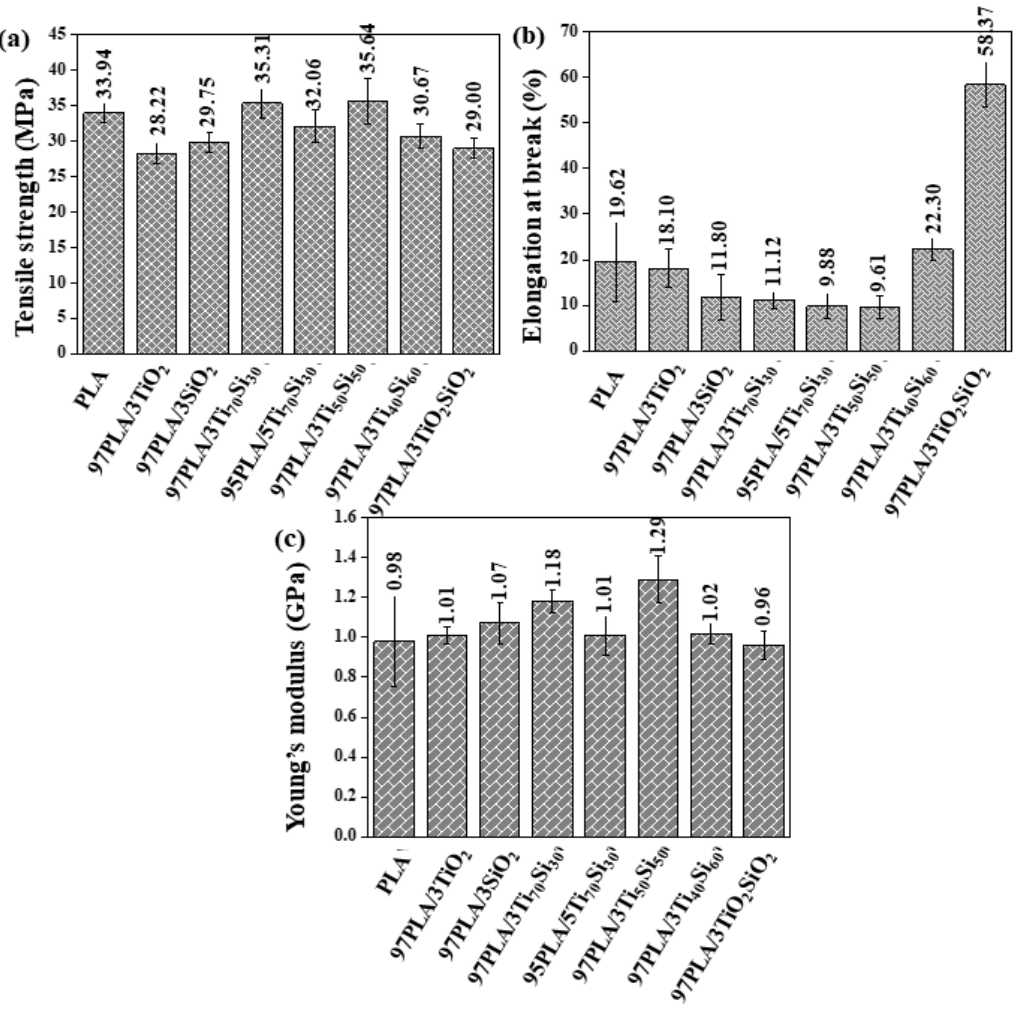
Figure 2. Comparison of the ( a ) Tensile strength, ( b ) Elongation at break, and ( c ) Young’s modulus of PLA, PLA/TiO 2 , PLA/SiO 2 , PLA/Ti x Si y , and PLA/TiO 2 SiO 2 composites .